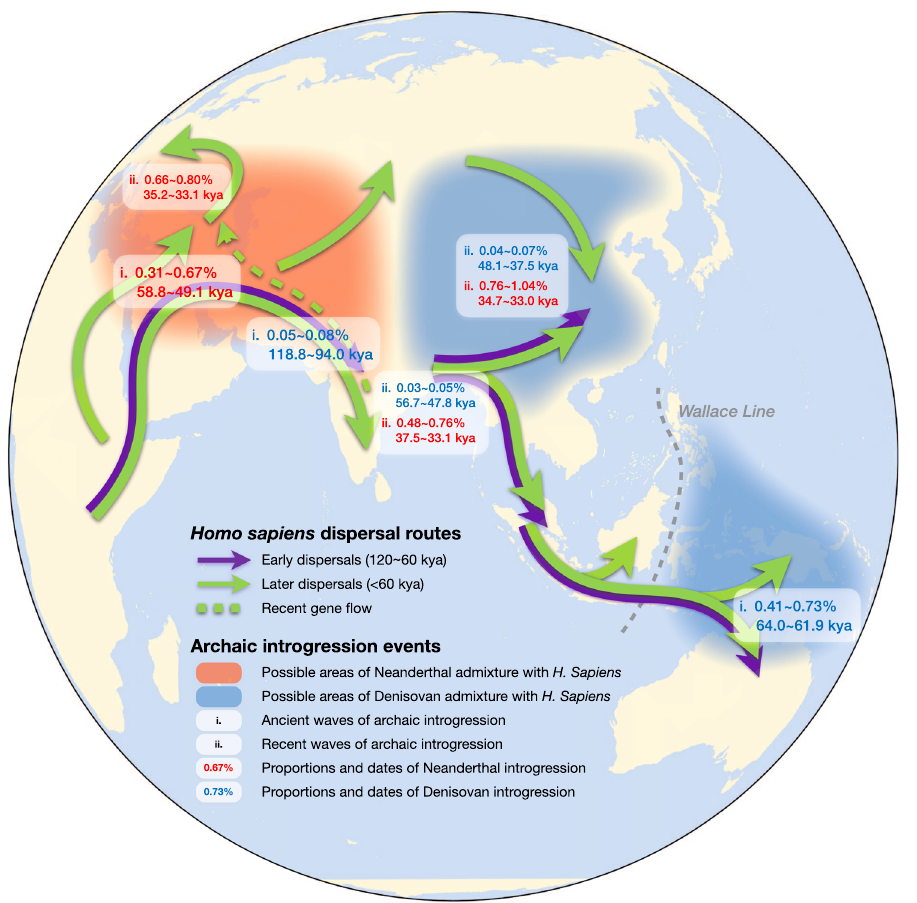
Fig. 5 Map of Homo sapiens dispersal routes and admixture between archaic and modern humans. Migration pathways of H. sapiens are supported by archeological evidence. Translucent red and blue represent possible ranges for contact between archaic and modern humans. The waves, admixture proportions, and dates inferred in our study are labeled in boxes in white. kya thousand years ago.